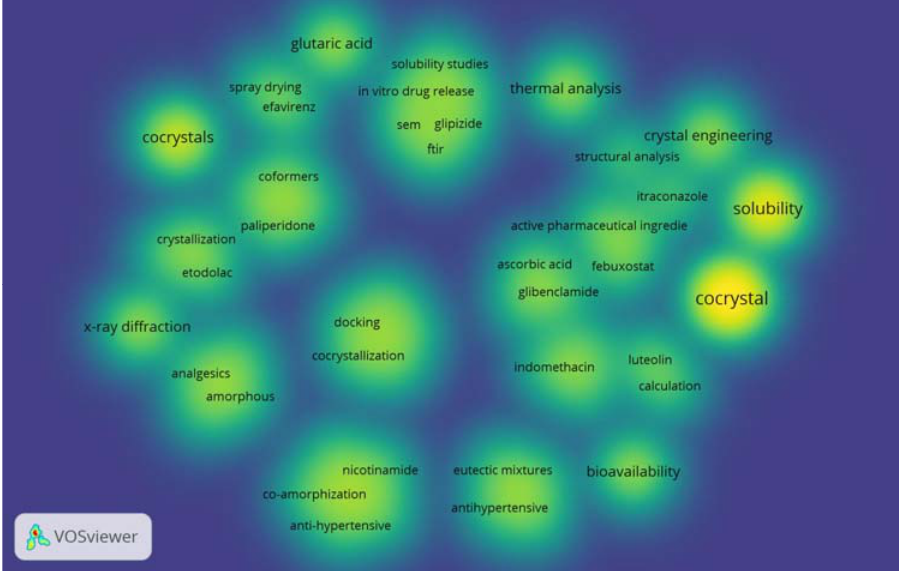
Figure 1. The density of coformer research in last 5 years.